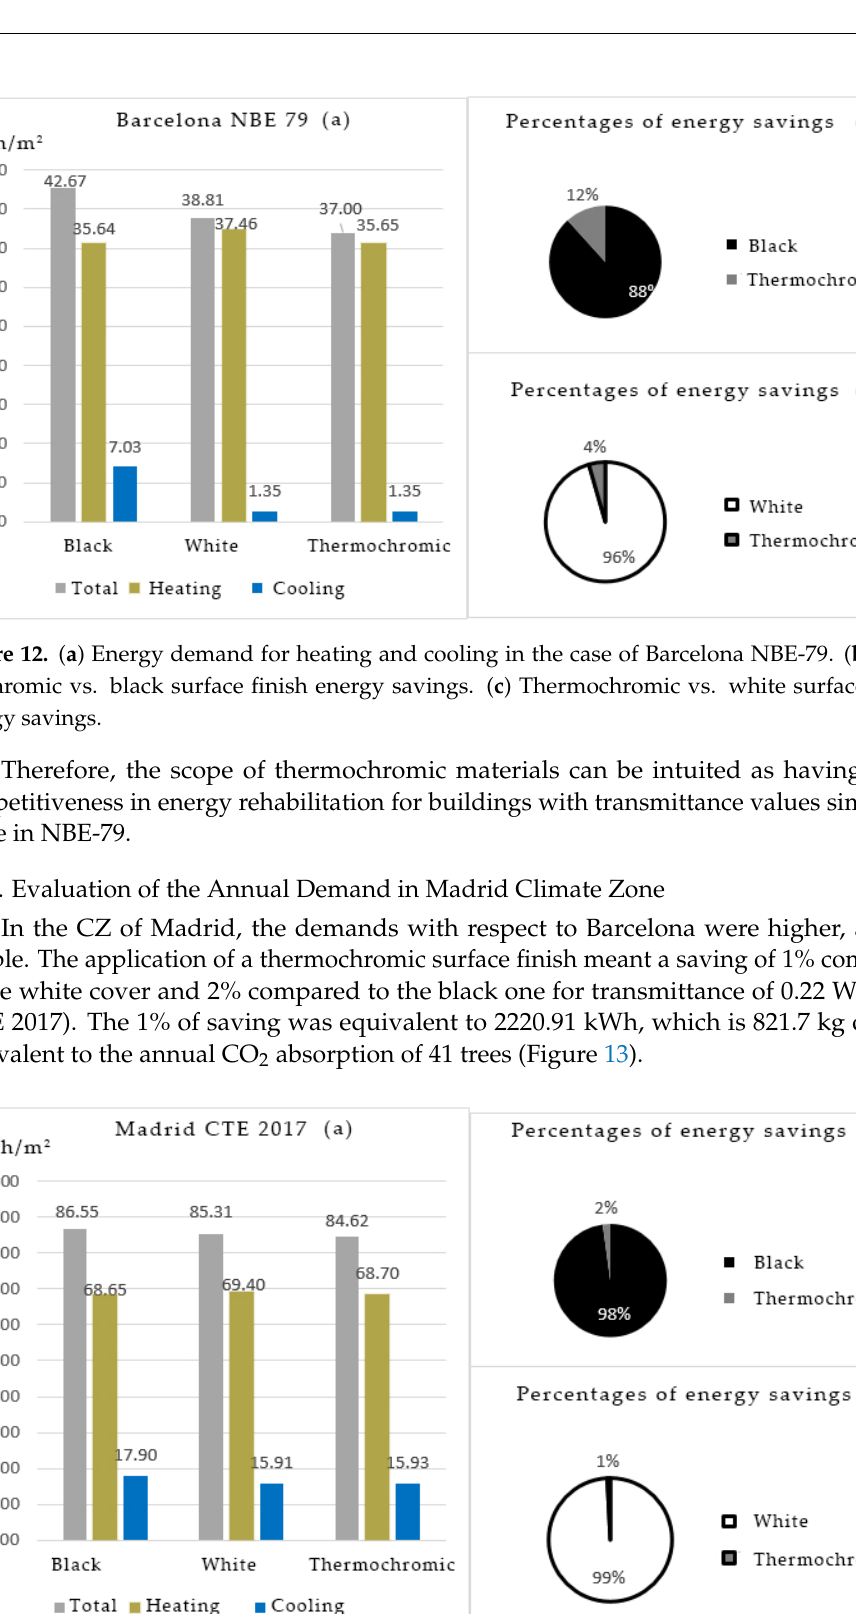
Figure 14. ( a ) Energy demand for heating and cooling in the case of Madrid CTE 2006. ( b ) Thermo- chromic vs. black surface finish energy savings. ( c ) Thermochromic vs. white surface finish energy savings.